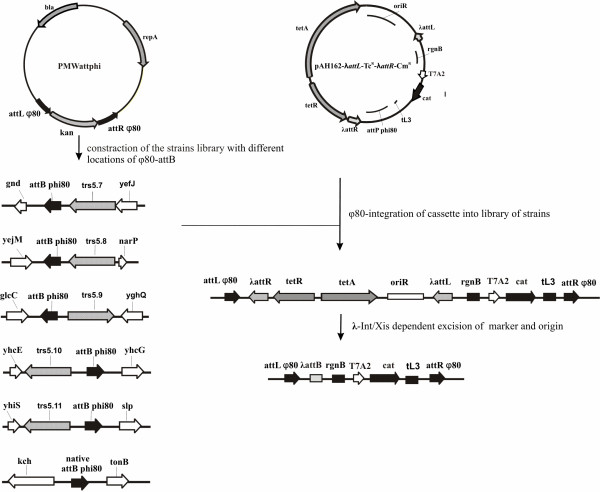
Integration of plasmid pAH162-λattL-TcR-λattR-CmR into MG1655-derived strains with different location of φ80-attB.